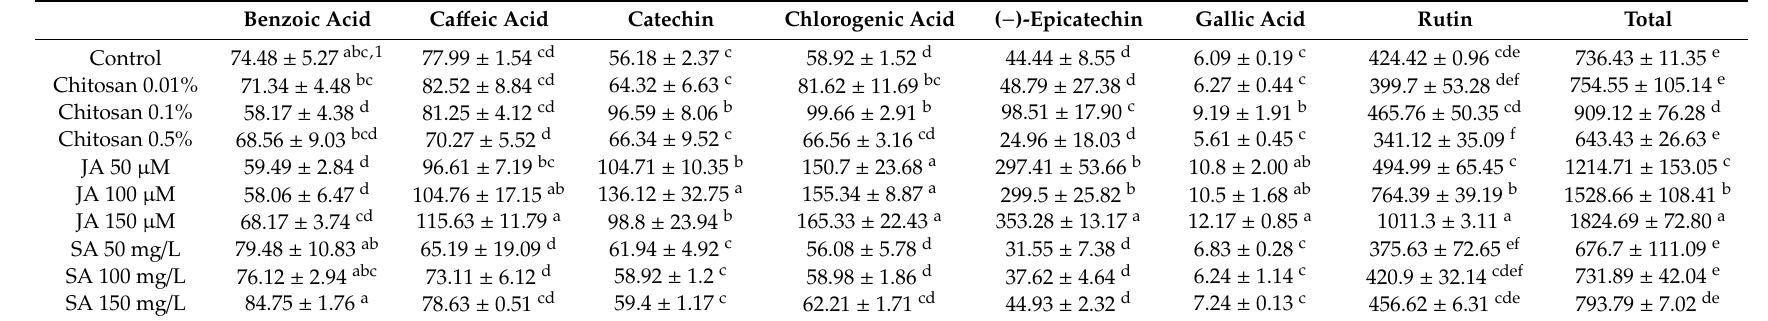
Table 1. The e ff ect of elicitors (chitosan, jasmonic acid (JA), salicylic acid (SA)) on the accumulation of phenolic compounds ( µ g / g (dw)).